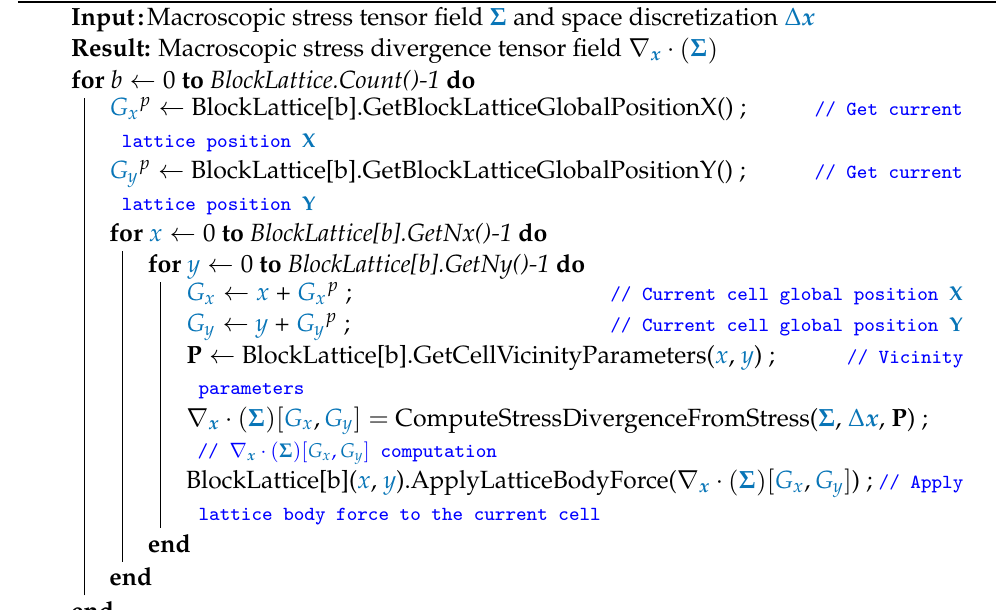
Algorithm 3: Body Force Routine [Physical